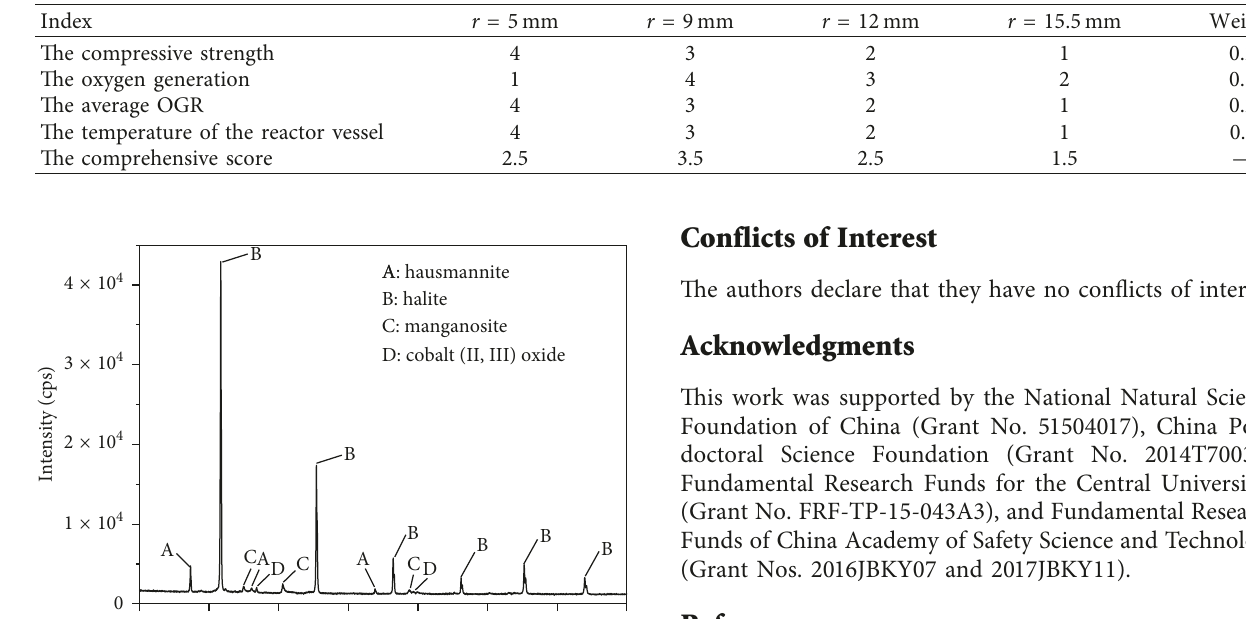
Table 2: The number, the weight, and the comprehensive score of each indicator.